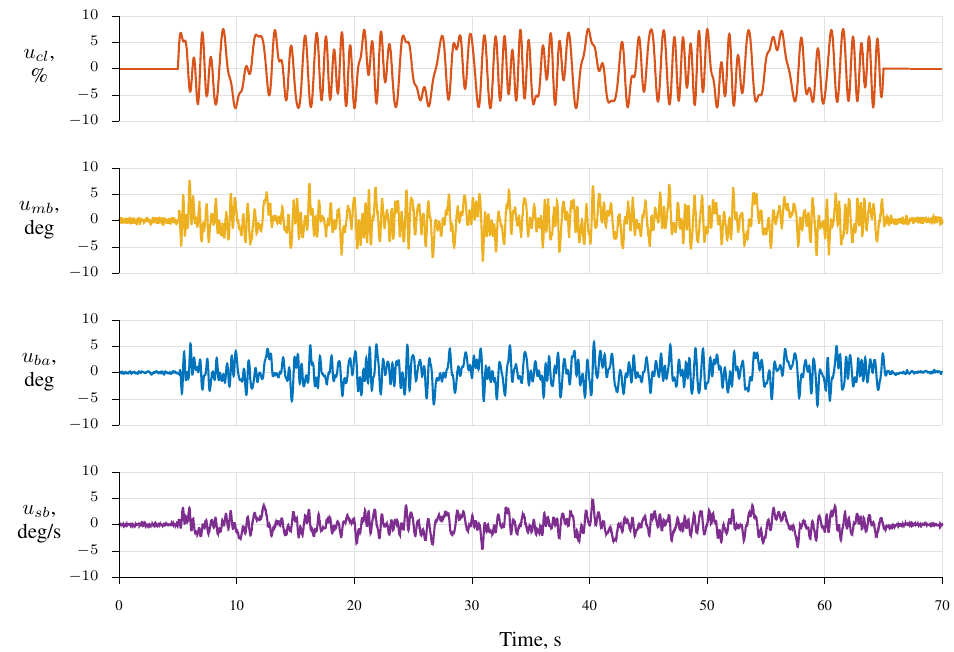
Figure 9. The X-59 loop input time